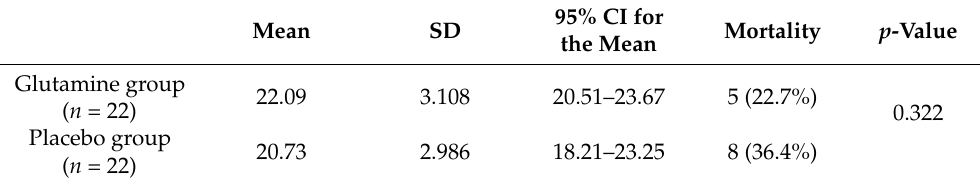
Table 4. Kaplan–Meier survival curve for overall